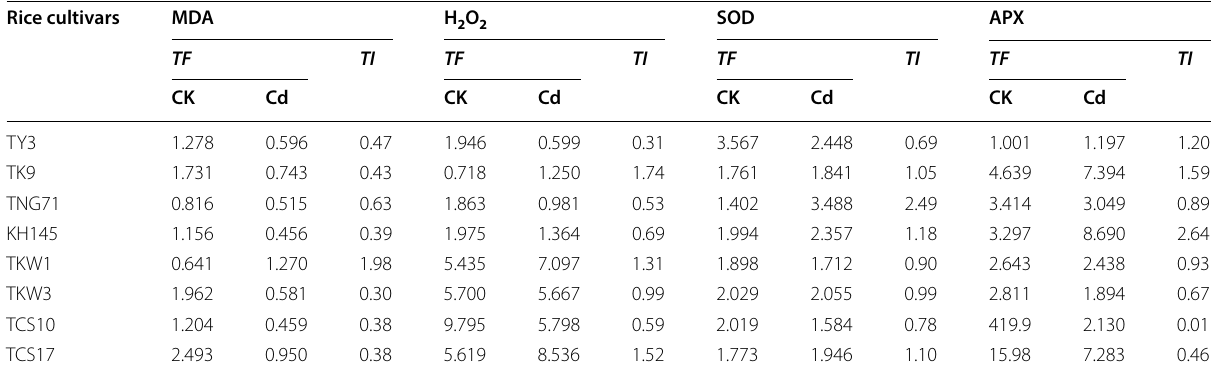
Table 2 Genotypic variations in the translocation factor ( TF ) values for the selected physiological traits, malondialdehyde (MDA), H O , superoxide dismutase (SOD), and ascorbate peroxidase (APX), and in the tendency index 2 2 ( TI ) values for the Cd treatment relative to a check (CK) among the rice cultivars Rice cultivars